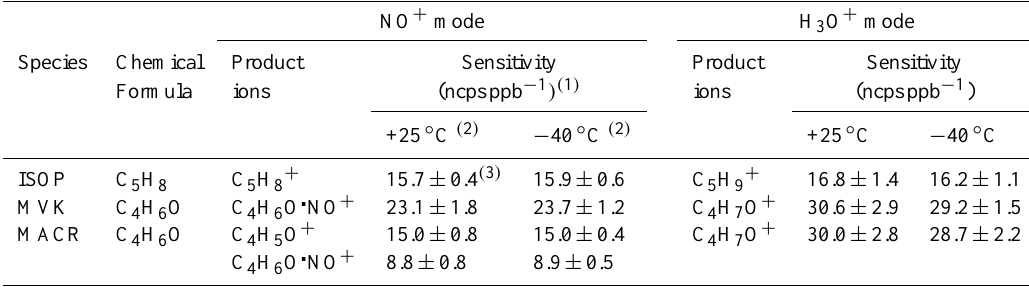
Table 2. Sensitivities of the PTR-TOF-MS to ISOP, MVK, and